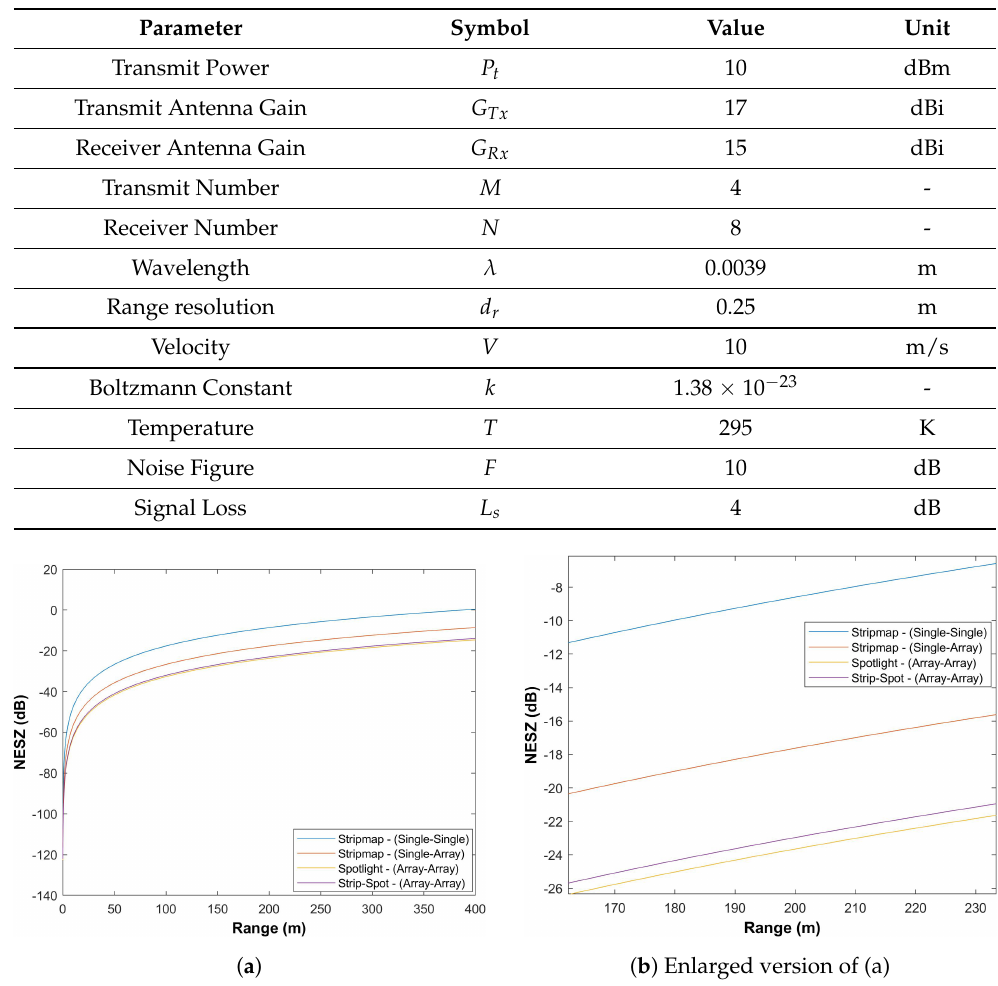
Figure 19. Sensitivity analysis comparison based on Table